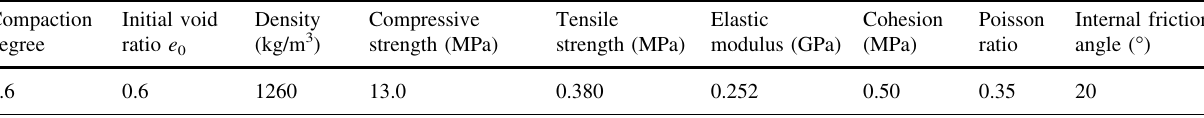
Table 2 Mechanical parameters of the backfilling